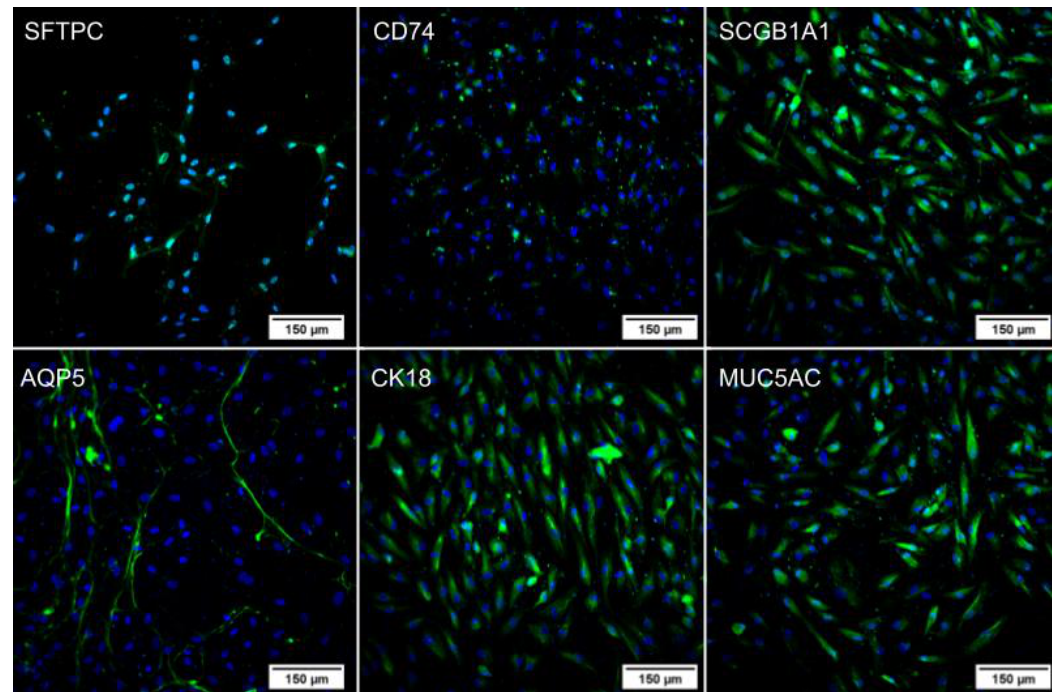
Figure 3. Immunocytochemistry of lung organoids (sample C10) with DAPI marking the nuclei in blue and FITC labeling the specific proteins in green. Images obtained using a high-throughput mi- croscope In Cell Analyzer 2000 (GE Healthcare ® , Chicago, IL, USA).